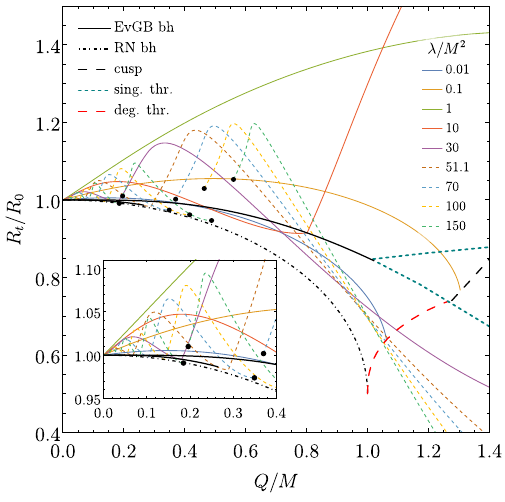
Fig. 12 Zoom of Fig. 11